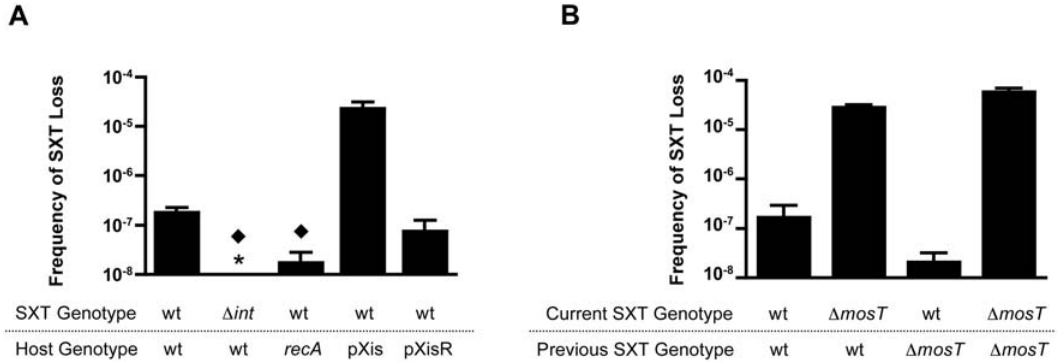
Figure 2. Influence of genetic factors on the frequency of SXT loss. The frequency of SXT loss was calculated as the ratio of Spec R Cm S cfu / total cfu after 15 hour of growth. A) Factors that influence the frequency of SXT excision alter the frequency of SXT loss. The black diamonds indicate that the result is statistically different (p , 0.05) than the result shown in the first column for the wild type reporter. The * signifies that the result was below the limit of detection which was , 1 6 10 2 8 . pXis and pXis-R harbor arabinose-inducible xis or its reverse complement respectively. B) SXT loss is not accompanied by heritable changes that influence maintenance of SXT. The ‘current SXT genotype’ refers to the ICE introduced into the host that lost the ICE designated as ‘previous SXT genotype’.